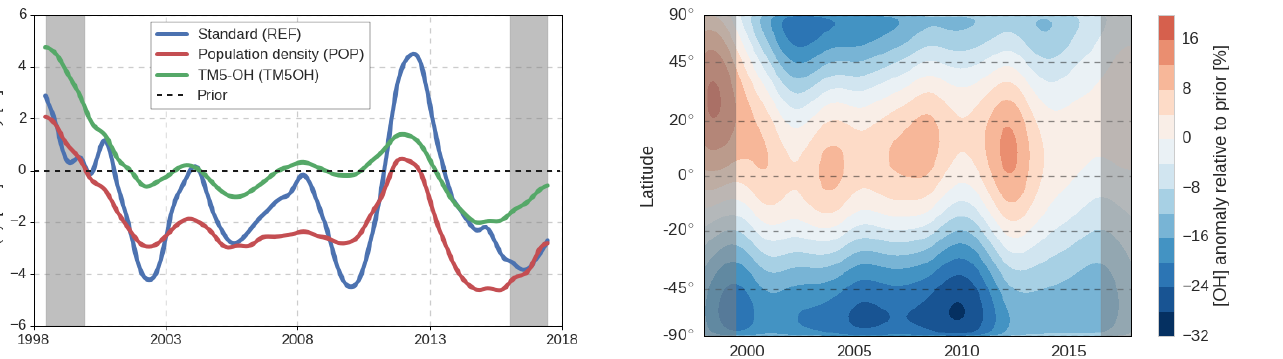
Figure 2. Hovmöller diagram of the spatiotemporal adjustments made to [OH] in the REF inversion setup. The prior [OH] distri- bution, with respect to which changes are shown, is based on Spi- vakovsky et al. (2000), scaled down by a factor 0.92. Gray bars indicate a spin-up and spin-down period of 1.5